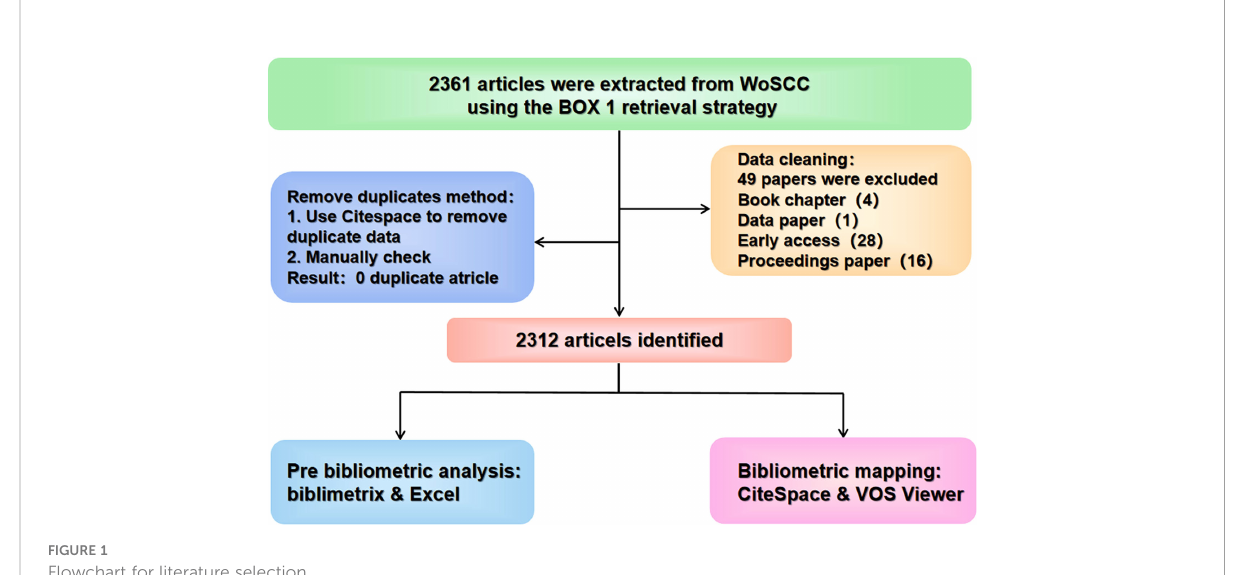
FIGURE 1 Flowchart for literature